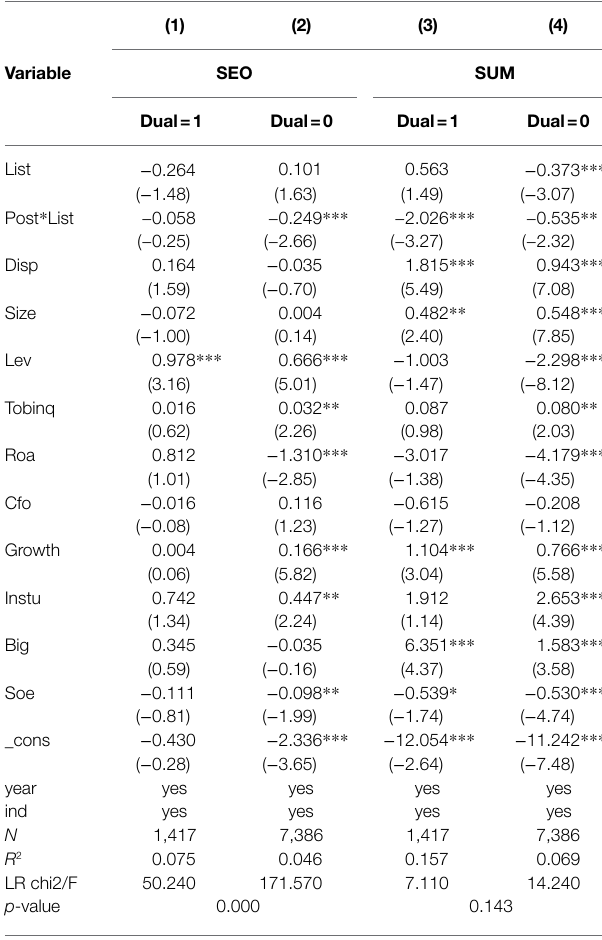
TABLE 7 | Deregulation of short selling and private placement of companies: whether to combine the two